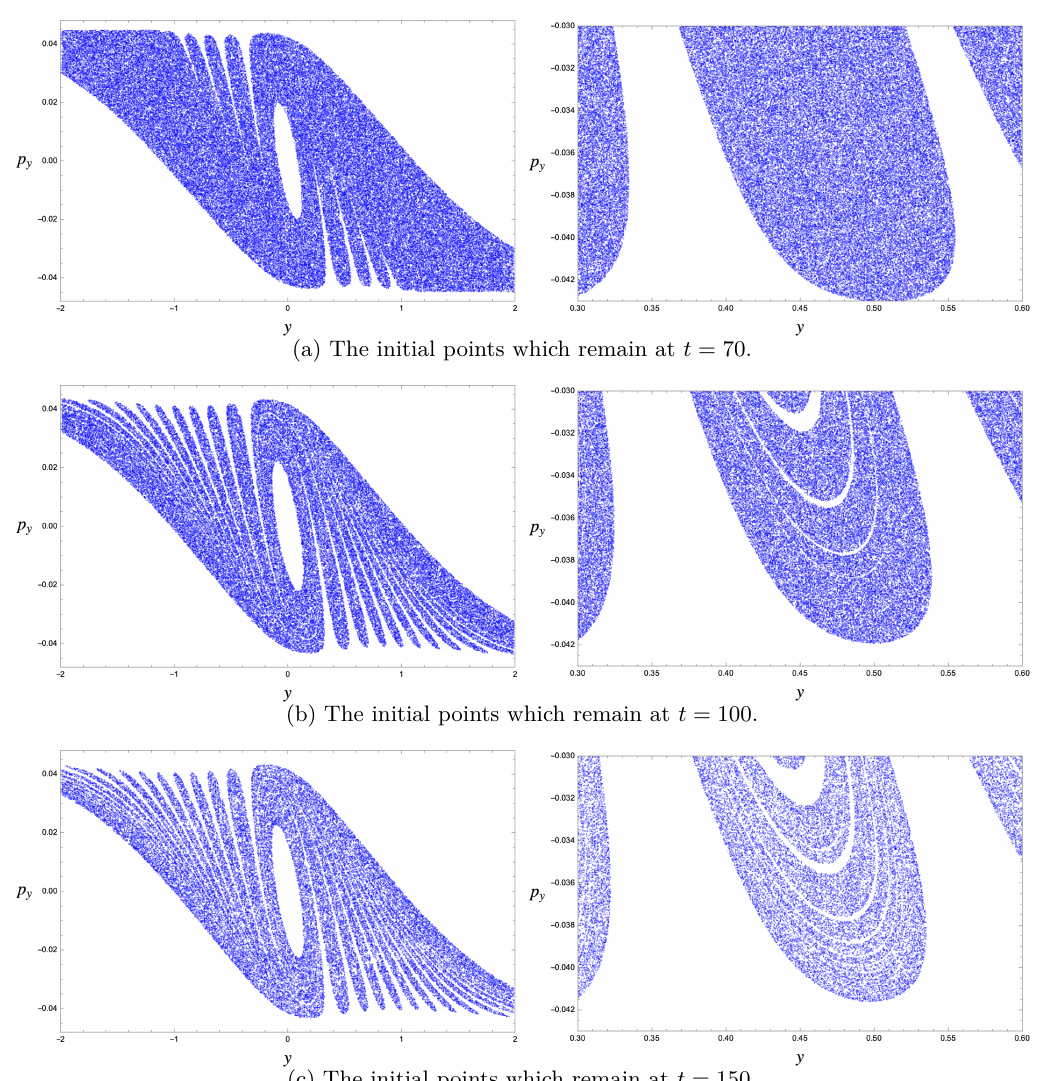
Figure 3 . The initial conditions which remain in the chaotic region B . The other parameters are set to x = 0 , p x > 0 and E = 0 . 001 . The figure on the right is an enlargement of the area of 0 . 3 < y < 0 . 6 and − 0 . 043 < p y < − 0 . 03 in the figure on the